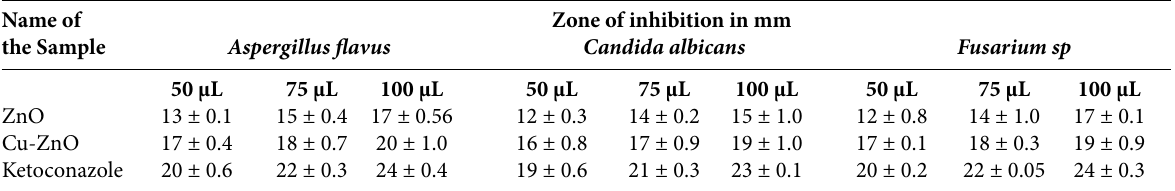
Table 2. Antifungal activity of Cu-ZnO NPs Name of